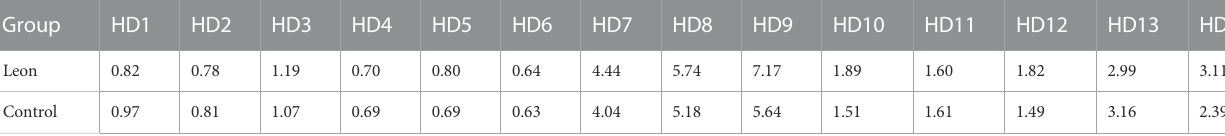
TABLE 4 The MFI of CD83 expression on moDCs (×105) (HD-moDCs, n = 14).